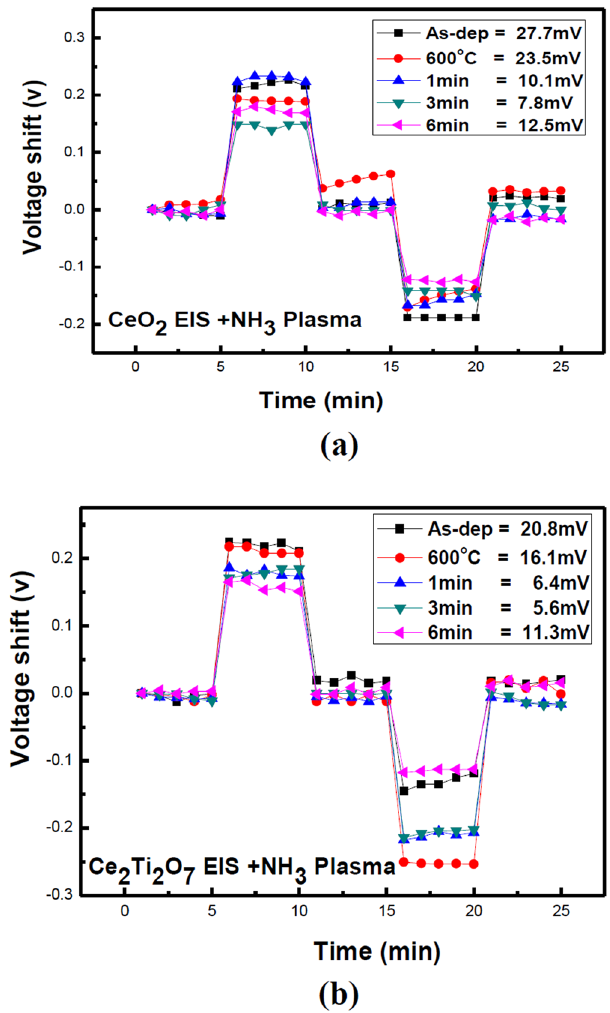
Figure 8. The hysteresis of ( a ) CeO 2 and ( b ) Ce 2 Ti 2 O 7 sensing membrane with NH 3 plasma treatment in various conditions during a pH loop of 7 → 4 → 7 → 10 → 7 over a period of 25